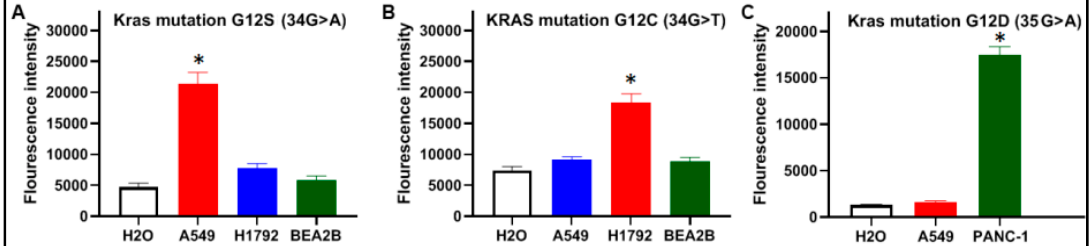
Figure 4. Specificity of CRISPR–Cas12a with crRNAs for the detection of KRA mutations: ( A ) CRISPR–Cas12a with crRNA targeting KRAS 12S identified the mutation only in the DNA of A549 cells that carry KRAS 12S; ( B ) CRISPR–Cas12a with crRNA targeting KRAS 12C detect the mutation only in the DNA of H1792 cells that carry KRAS 12C; and ( C ) CRISPR– Cas12a with crRNA targeting KRAS 12D detect the mutation only in the DNA of PANC-1 cells that carry KRAS 12D. (* p < 0.05).